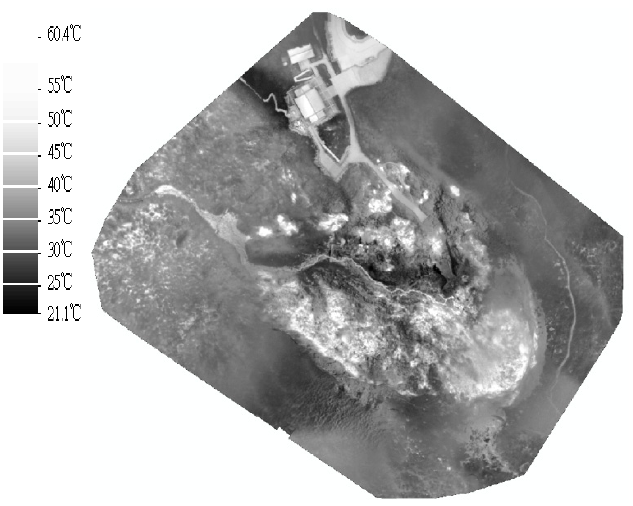
Figure 13. Thermal orthoimage. Figure 13. Thermal